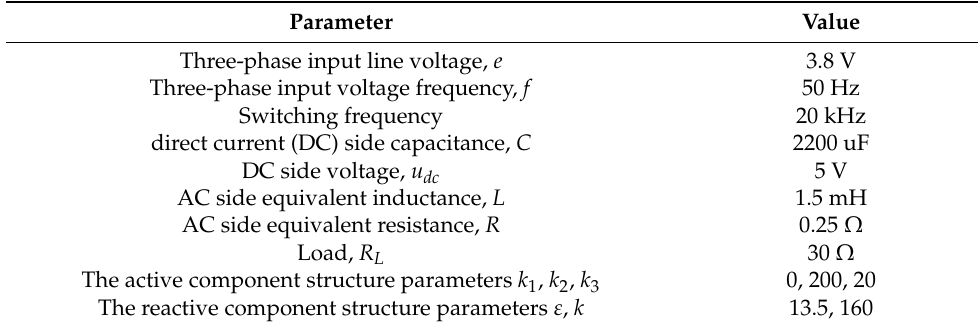
Figure 2. Simulation model of DC voltage control system. Table 1. Simulation circuit